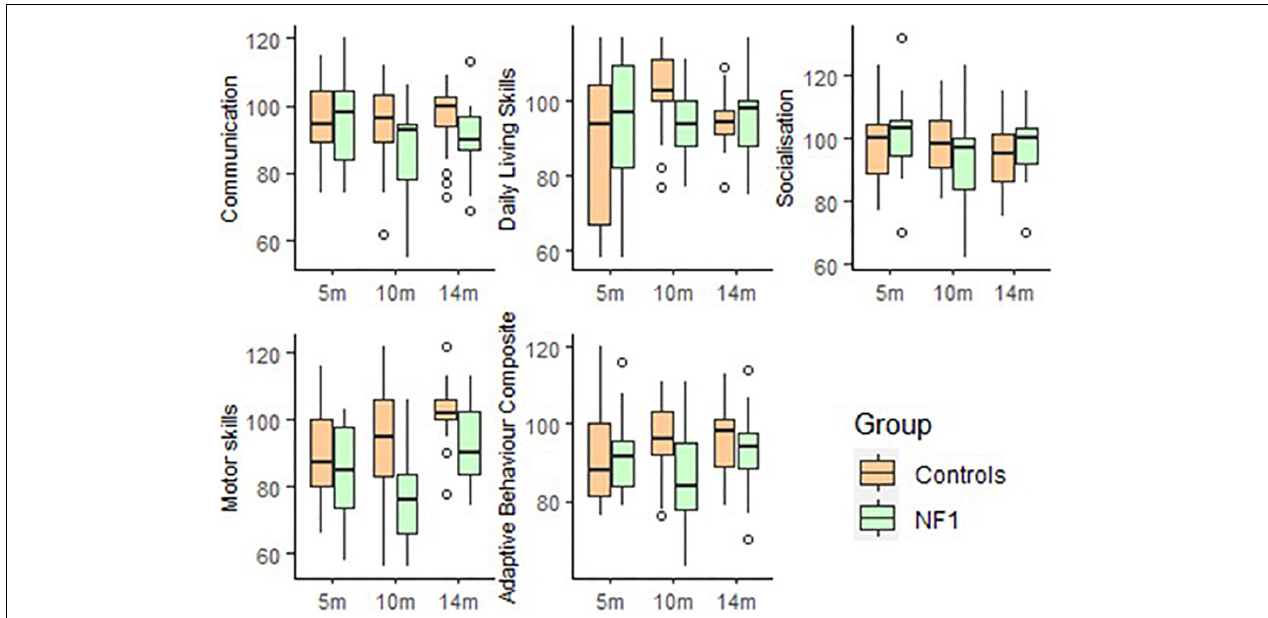
FIGURE 3 | Box-whisker plots of the NF1 and control groups on the Vineland Adaptive Behaviour Scale.